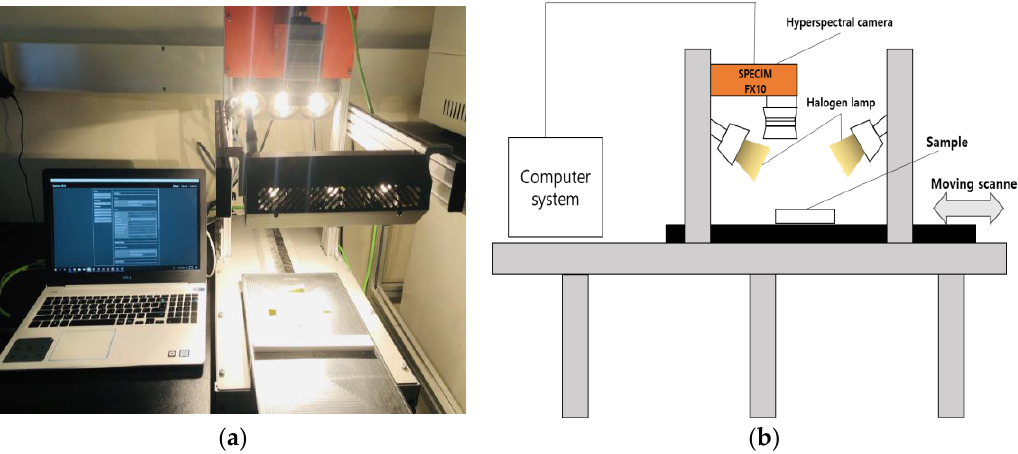
Figure 2. Red, green, and blue (RGB) images of ( a ) Brown, ( b ) Yellow, and ( c ) Red soils after No. 40 sieve analysis.